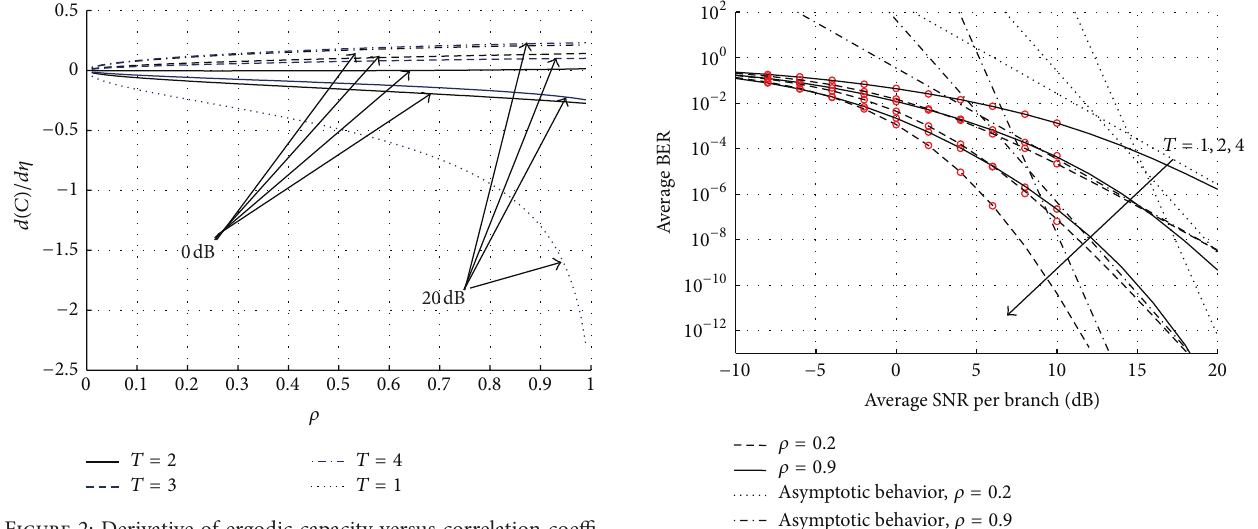
Figure 2: Derivative of ergodic capacity versus correlation coeffi- cient 𝜌 for 𝑅 = 2 ; 𝑇 = 1, 2, 3, 4 . Average SNR per branch is 0 dB and 20 dB.